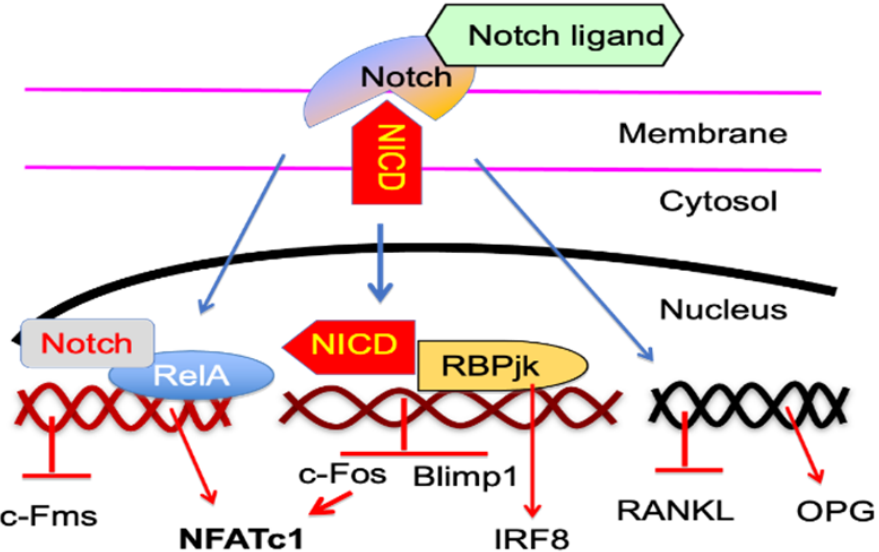
Figure 3. Notch signaling regulation of OC differentiation. Notch ligand binding to Notch receptors results in the cleavage and release of Notch NICD. As a result, NICD translocates into the nucleus, where it associates with RBPj κ and NF- κ B to regulate the transcription of genes that control OC differentiation. NICD association with RBPj κ inhibits the expression of NFATc1 by attenuating c- Fos, and suppressing Blimp1, and promotes IRF8 expression. Notch also inhibits cFms expression, but associates with NF- κ B RelA to promote NFATc1 expression. In addition, Notch inhibits OC differentiation, indirectly downregulating RANKL, while promoting OPG expression by MPCs and osteocytes.